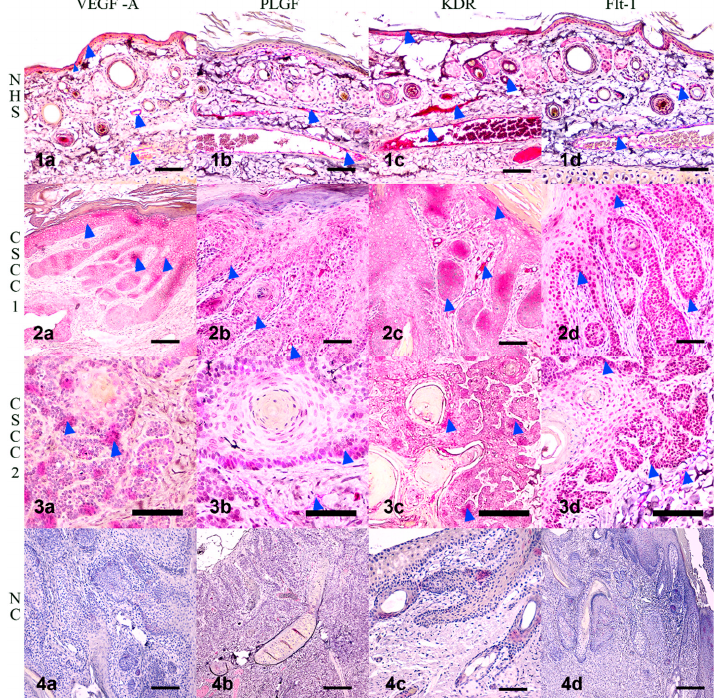
Figure 6. Immunolocalization of angiogenic biomarkers in NHS and CSCC. ( 1a ) VEGF-A immunoreactivity in normal pinna in blood vessels, apocrine glands, and keratinocytes. ( 2a , 3a ) VEGF-A immunoreactivity in SCC, associated with neoplastic cells under hyperplastic and dysplastic keratinization. ( 4a ) Negative control for VEGF-A ( 1b ) PLGF immunoreactivity in the endothelium of blood vessels in the normal pinna. ( 2b , 3b ) Prominent immunoreactivity of PLGF in SCC keratinocytes of the stratum basale and accompanying the increased vascularization in the periphery of the tumor. ( 4b ) Negative control for PLGF ( 2c , 3c ) KDR and Flt-1 immunolocalized in blood vessel endothelium and in SCC tumoral cells. ( 4c ) Negative control for KDR ( 1c ) Marked increase in immunoreactive KDR in CSCC compared to pinna NHS. ( 1d ) Flt 1 immunoreactivity in apocrine glands and epithelium of blood vessels of NHS. ( 2d , 3d ) Flt 1 immunoreactivity localized to tumoral cells, especially in the stratum basale of the dysplastic epidermis in the periphery of dermal invaginations of tumoral keratinocytes ( 4d ) Negative control for Flt-1. Blue arrowheads point to positive immunostaining. NHS—normal haired skin from pinna; CSCC—cutaneous squamous cell carcinoma; NC—Negative control omitting primary antibody. Scale bar represents 200